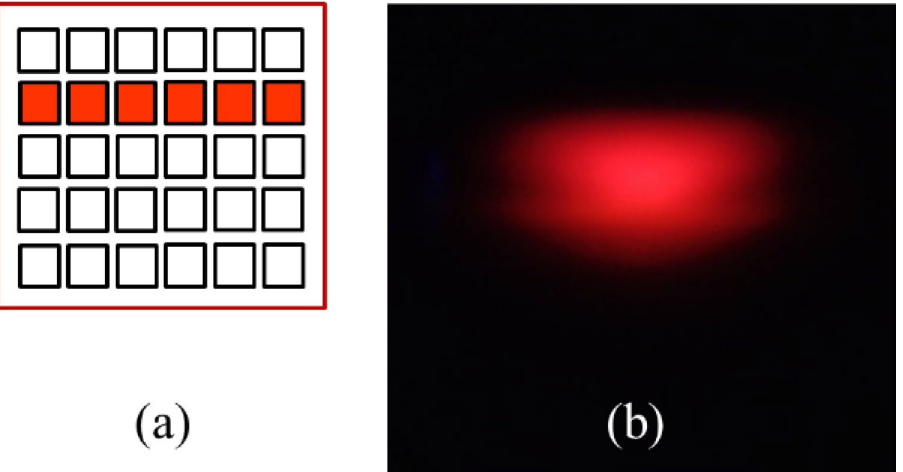
Figure 16. ( a ) The locations of the turn-on LED dies, and ( b ) the observed light pattern by the CCD camera with an IRLP filter at 720